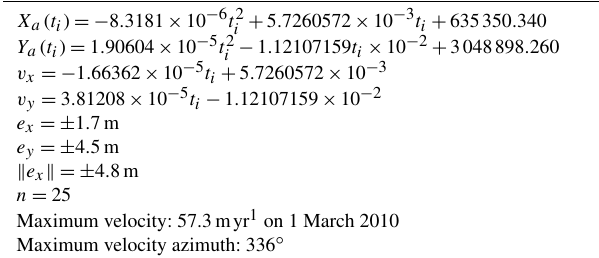
Table 2. Example of results for the adjustment by least squares of the position and the velocity of a stake (EJ14, near the calving front of Johnsons Glacier; see Fig. 3), together with the deviations from the polynomial approximation for the position, as well as the maxi- mum horizontal velocity and its